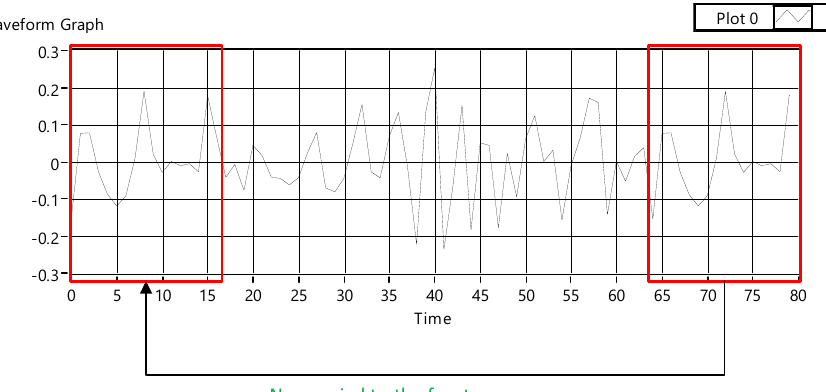
Figure 2 . Cyclic-prefix in RS-OFDM symbols . Figure 2. Cyclic-prefix in RS-OFDM